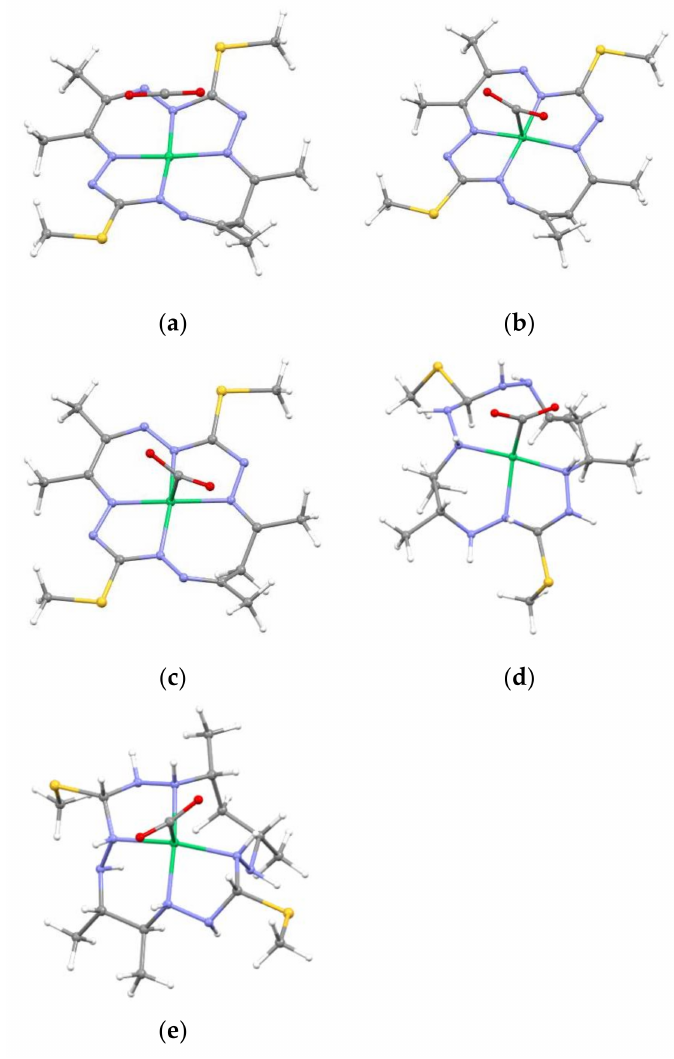
Figure 2. Structure of studied complexes with CO 2 : ( a ) 1 [ NiL-CO 2 ] 0 , ( b ) 1 [ NiL fr CO 2 ] 0 , ( c ) 3 [ NiL- CO 2 ] 2 − , ( d ) 1 [ NiLH-CO 2 ] 0 , and ( e ) 2 [ NiLH-CO 2 ] + . Colour scheme: green Ni, yellow S, blue N, grey C, and white